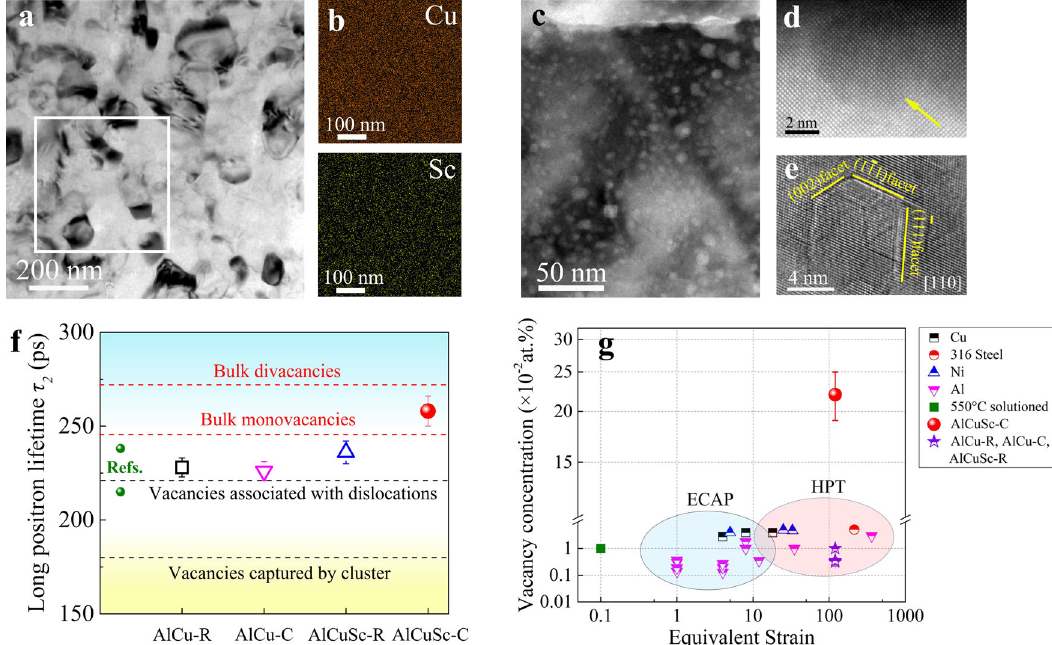
Fig. 1 A high vacancy concentration in the AlCuSc-C alloy. a Typical bright- fi eld TEM image showing the grains in the AlCuSc-C alloy. b EDS elemental mappings of Cu and Sc elements in the area marked by the rectangular framework in a . c Typical bright- fi eld TEM image of the AlCuSc-C alloy after ion milling at low energy (3.1 kV) and low incidental angle (4°) for 20 min. d Typical atomic-resolution HAADF-STEM image viewed along <100> Al showing a void. e High-resolution TEM image viewed along <110> Al showing the void. f Measured positron annihilation lifetime of the AlCu-R, AlCu-C, AlCuSc-R, and AlCuSc-C alloys, compared with typical values of room temperature HPT-processed Al alloys in refs. 19,30 . The error bars represent standard deviations from the mean for sets of three tests. g A comparison of vacancy concentrations between the AlCu-R, AlCu-C, AlCuSc-R, AlCuSc-C alloys, and other SPD- processed alloys, including Cu 34 , 316 steels 35 , Ni 34,36 , and Al alloys 18,31 . The error bar on the red data point represents standard deviations from the mean for sets of three